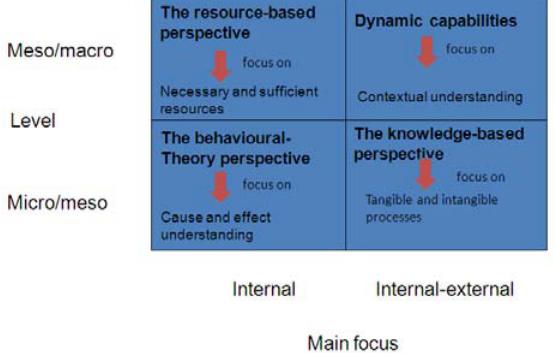
Fig. 2. The knowledge base and levels of strategic HR management: A